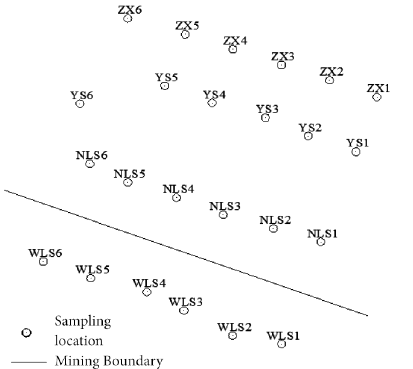
Figure 1. The layout of sampling points in the loess region